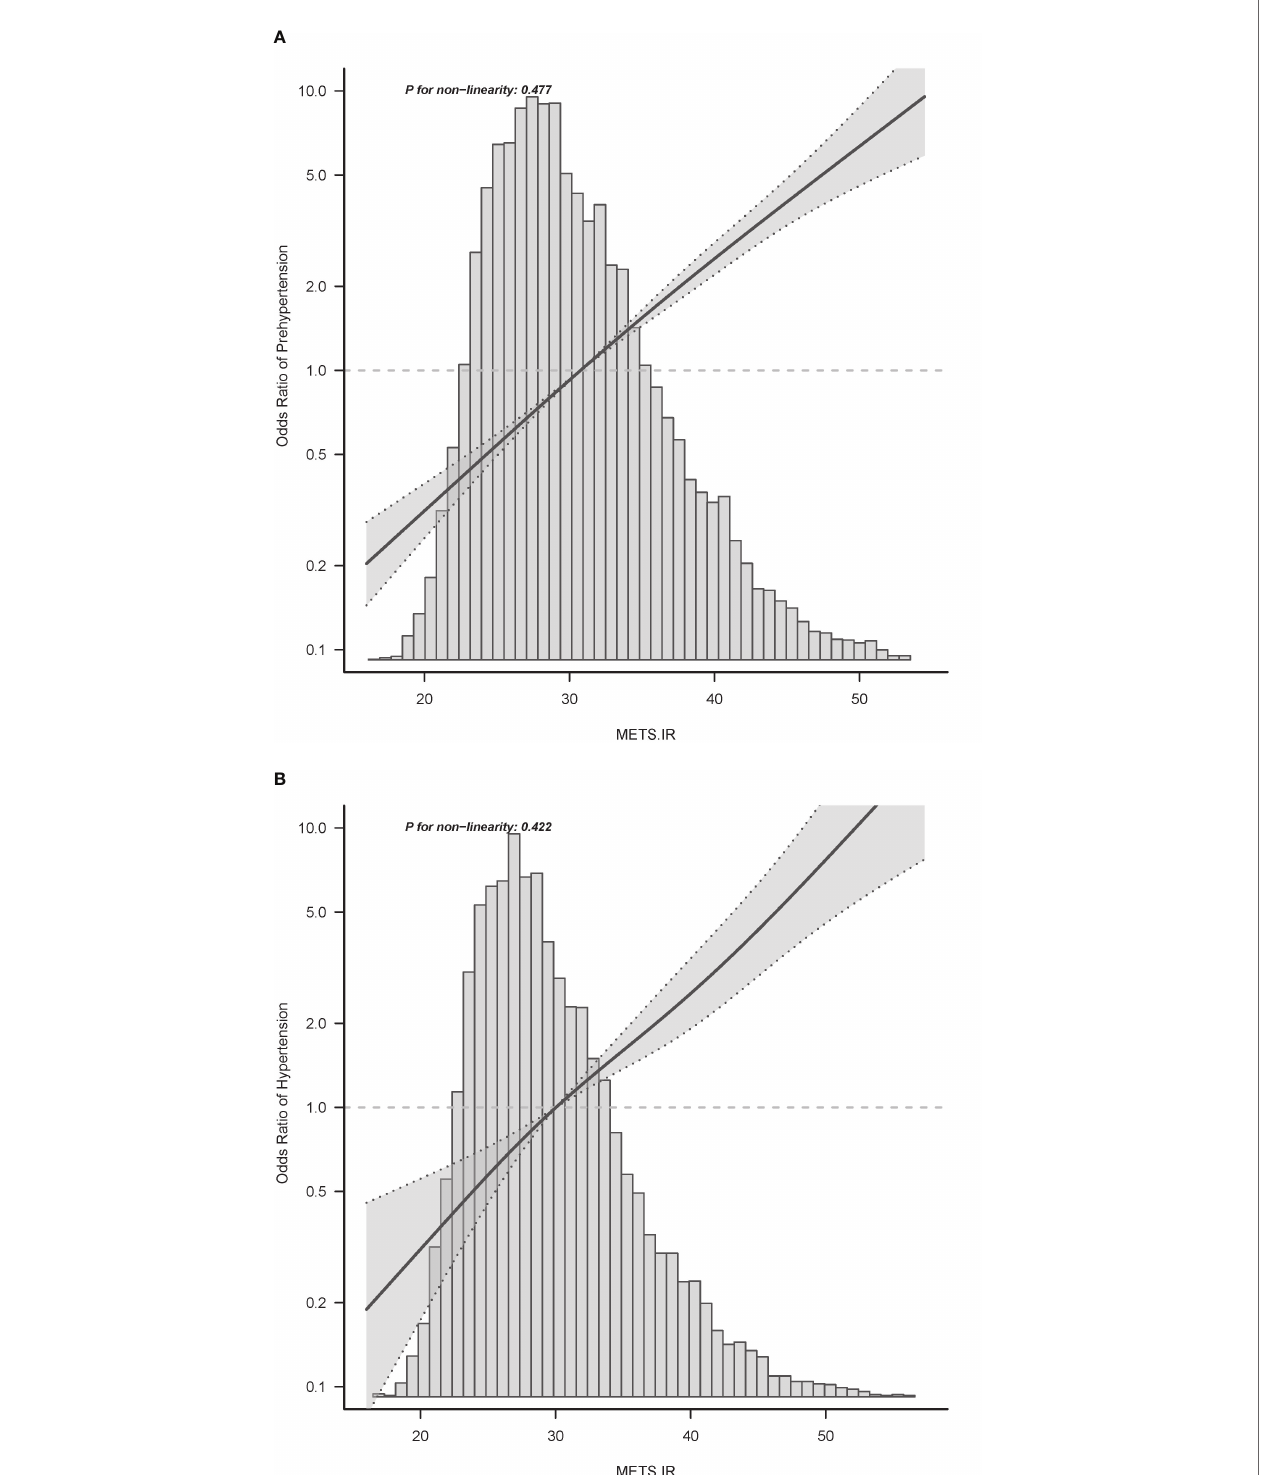
FIGURE 2 | Associations between METS-IR index with prehypertension (A) or hypertension (B) . Odd ratios (ORs) were adjusted for age (continuous), sex (male or female), waist circumference (<90 or ≥ 90 in Men and <80(cm) ≥ 80 in Women), smoking status (never, past and current), alcohol consumption (none, light, moderate and heavy), total cholesterol (continuous) and triglyceride (continuous). Both P linearity,